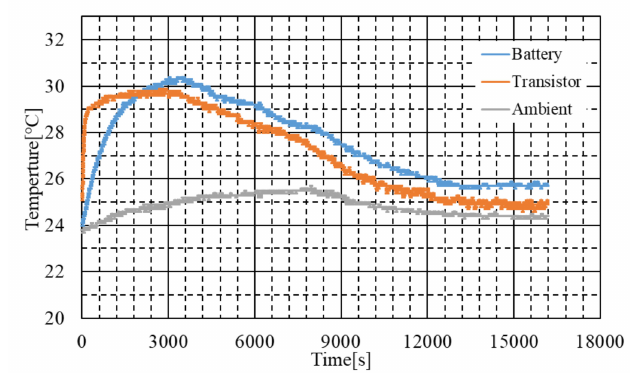
Figure 23. Cell’s temperature during the test on the proposed simulator.